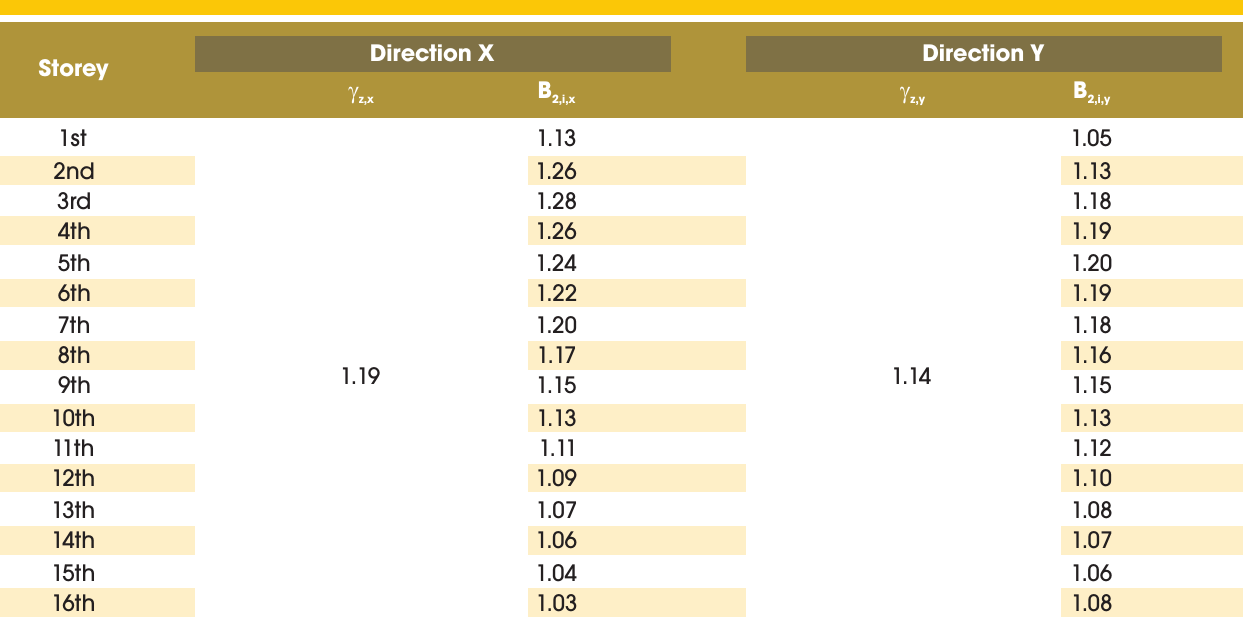
Table 3 – Values of the  and B in directions X and Y, for building I